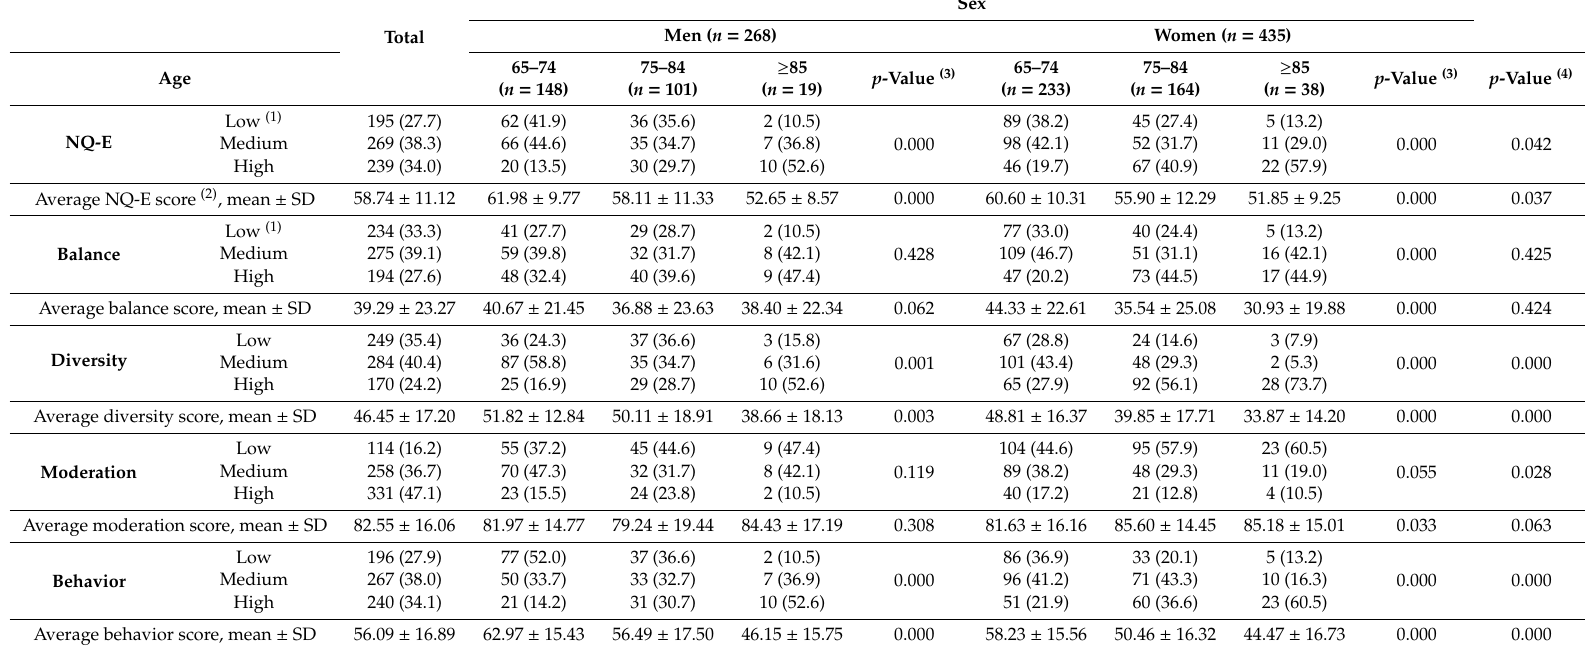
Table 2. The level and scores of the Nutrition Quotient for Elderly (NQ-E) by